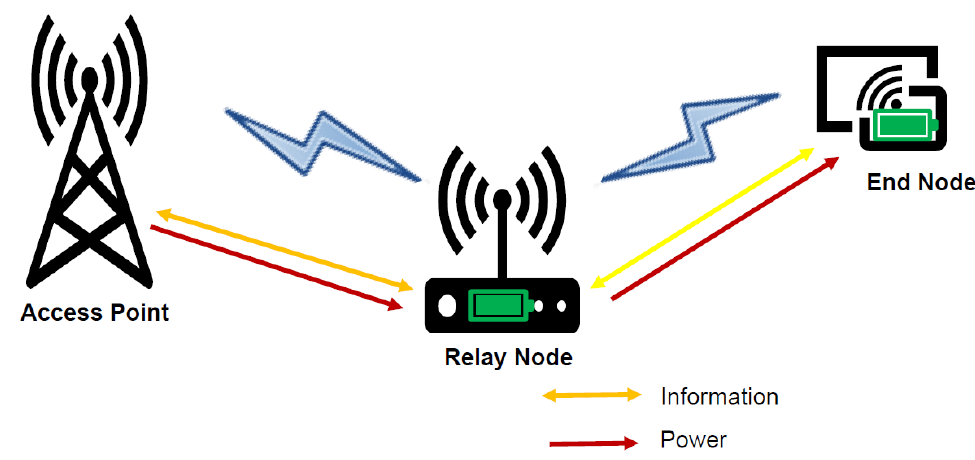
Figure 2. The two-hop relay network